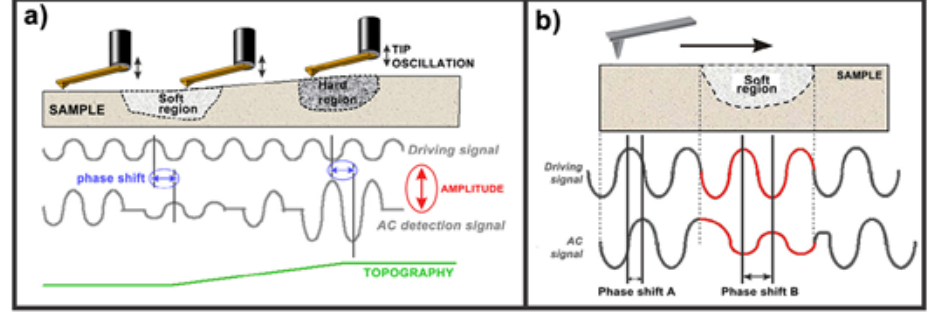
Figure 2. Lag changes due to the difference of mechanical properties of sample surface: a ) mode of modulation and b ) typical force curves [33,85]. Reproduction with permission of Elsevier. modulation and ( b ) typical force curves [33,85]. Reproduction with permission of Elsevier